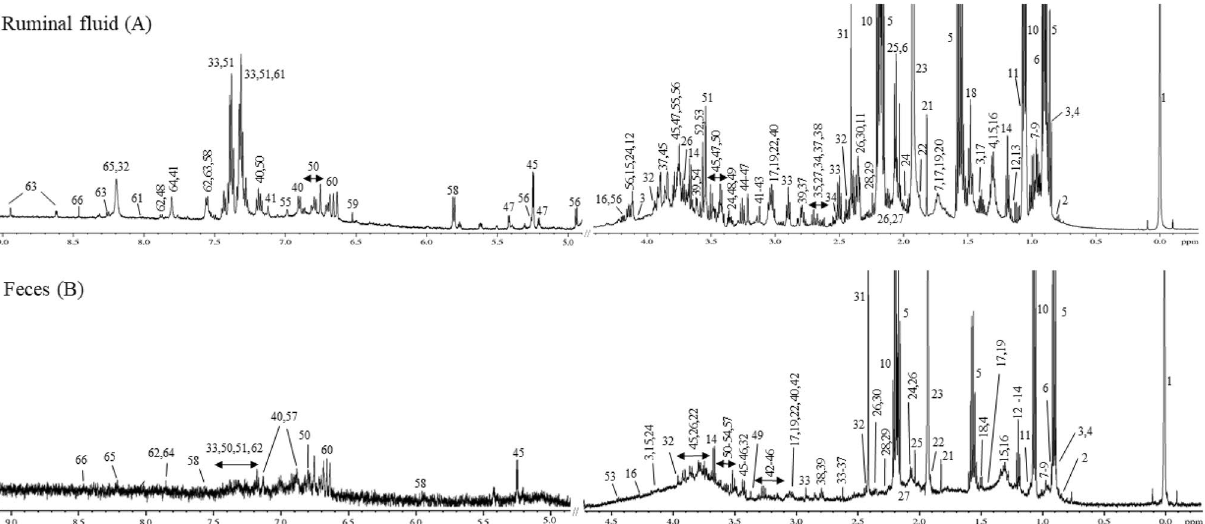
Figure 1. Representative 1 H NMR spectrum of ruminal fluid ( A ) and feces ( B ) of Nelore steers. 1: